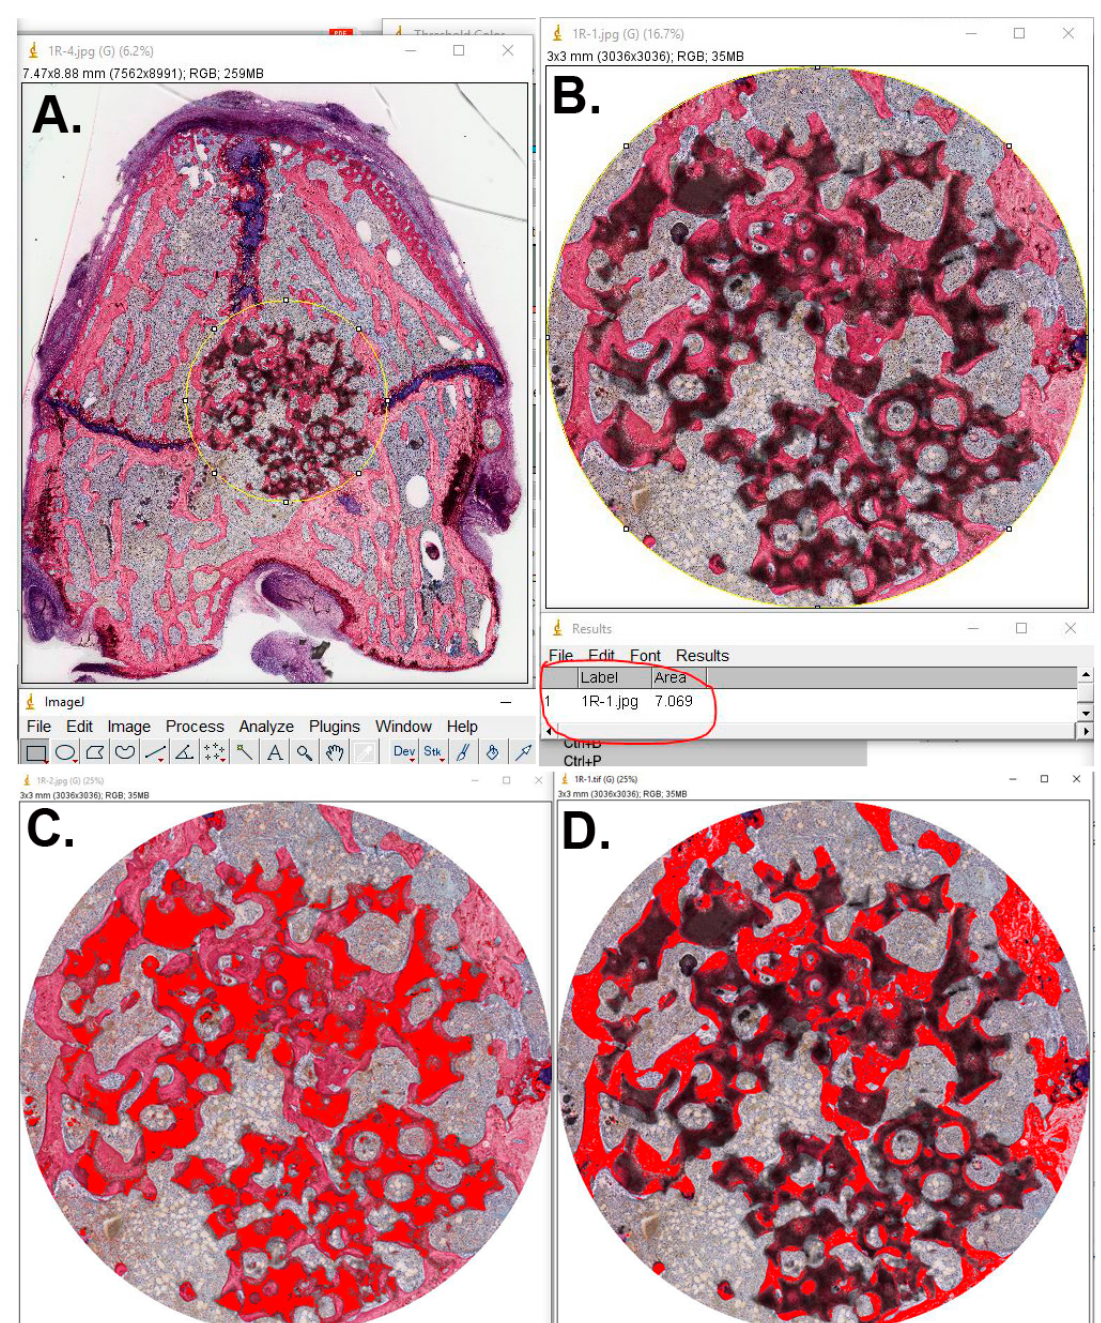
Figure 3. Representative histological sections showing histomorphometrical measurements using imageJ software. ( A , B ) A region of interest (ROI) measuring 3 mm in diameter and corresponding to the defect cross-section; ( C ) for selecting and measuring the percentage (%) of remaining biomaterials; ( D ) for identifying bone area in (%).